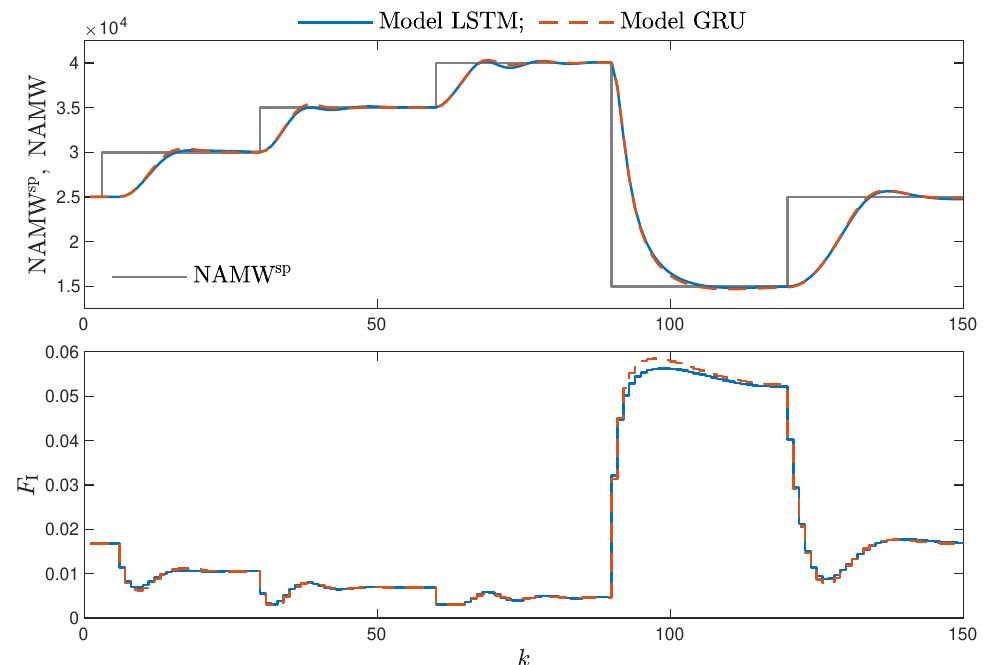
Figure 14. The polymerisation reactor: MPC results with the LSTM and GRU models n N = 9, n A = 0, n B =